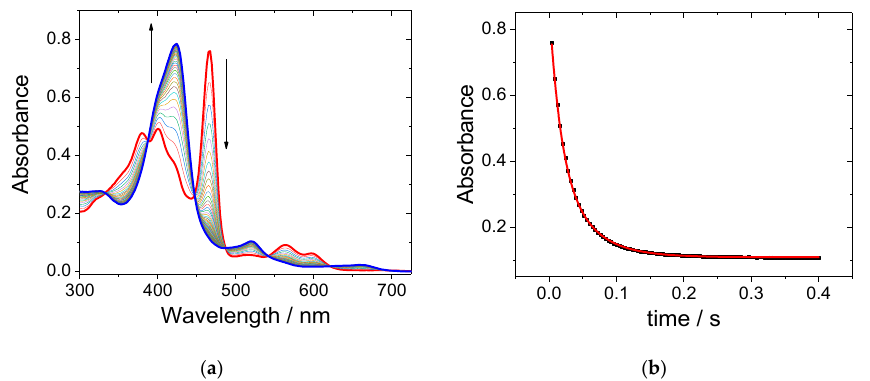
Figure 2. ( a ) Spectral changes recorded during the reaction of Mn III (TPPS) and peracetic acid (PAA) at pH = 11 in the presence of carbonate in solution. Spectrum just after mixing the reactants (red line) and after 0.4 s (blue line); ( b ) typical kinetic trace recorded at 466 nm. Experimental conditions: [Mn III (TPPS)] = 6 μ M, [PAA] = 50 μ M, [Na 2 CO 3 + NaHCO 3 ] = 0.5 M, T = 25 °C, total reaction time = 0.4